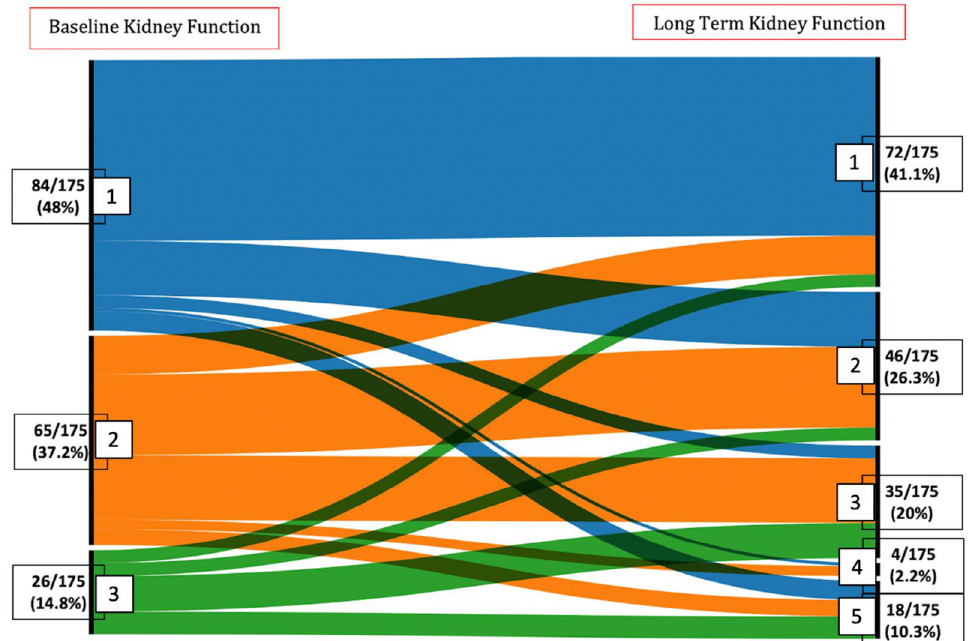
Fig. 4 Alluvial diagram illustrating CKD stages evolution according to eGFR from baseline to end of follow‑up. Each black bar represents an eGFR KDIGO stage at baseline (on the left of the diagram) and at the end of long‑term follow‑up (on the right of diagram). eGFR KDIGO stage: higher stages indicate more severe renal disease (see Additional file 1: Table S1 of the supplementary appendix).The height of the bars represents the proportion of patients. Alluvial diagram shows the evolution of the kidney function from baseline to long‑term follow‑up. The height of each stream represents the proportion of patient. Numbers and proportions of patients are presented next to each stage. Among these patients, 7 had CKD at baseline and eventually progressed from stage 3 to a higher stage of CKD, whereas 39 had normal renal function at baseline. Some patients had apparent eGFR improvement. This point is discussed in the text